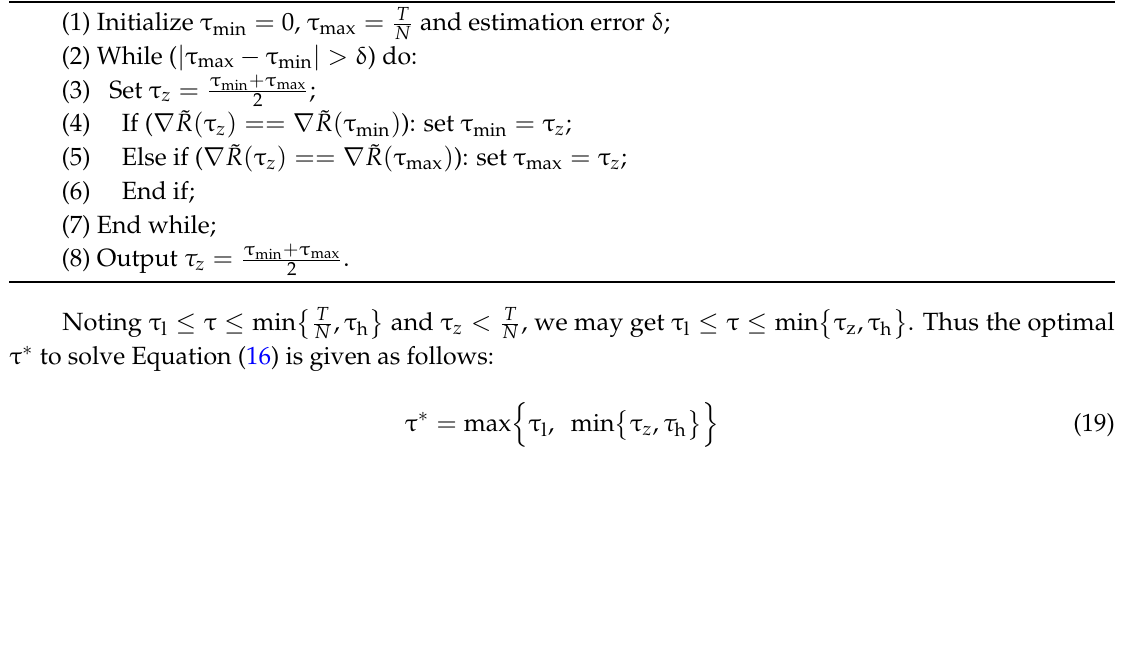
(cid:0) (cid:1) 0, T for maximizing ˜ R ( τ N